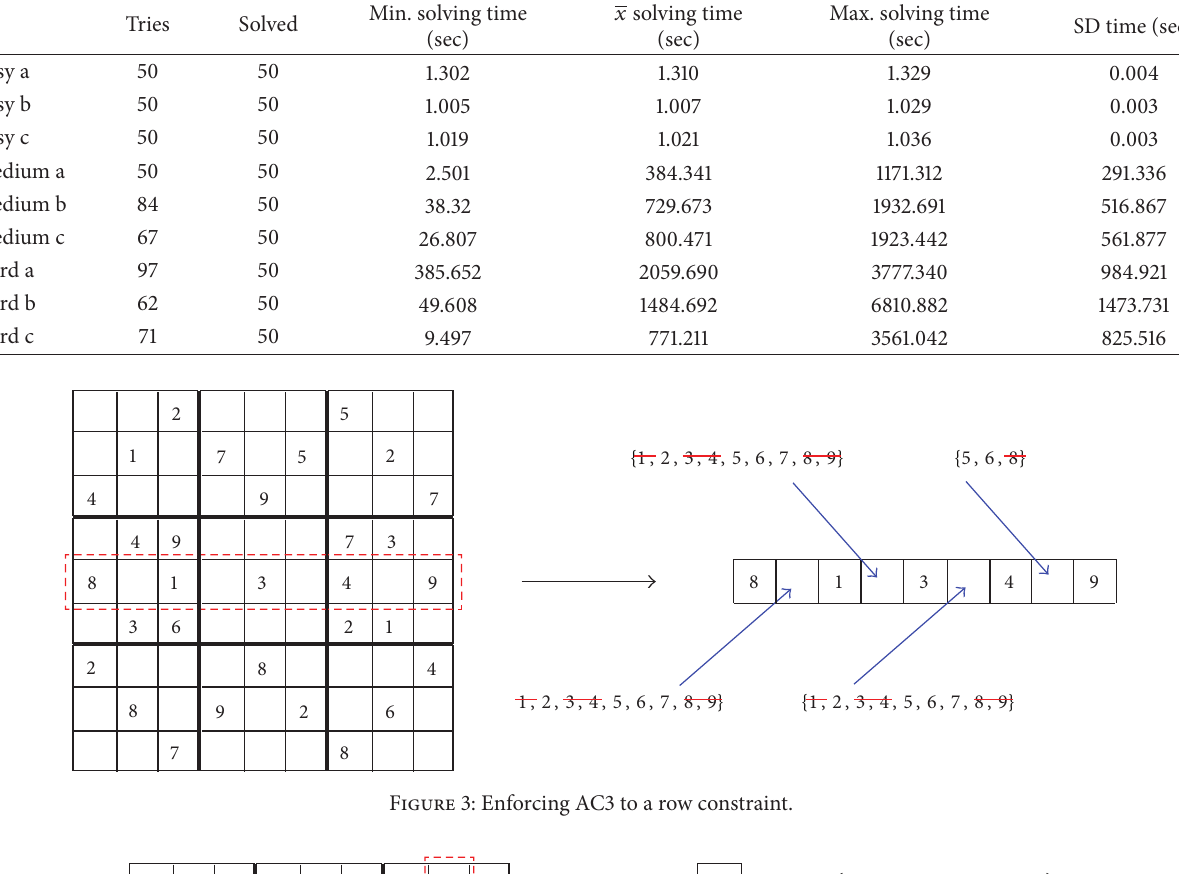
Figure 3: Enforcing AC3 to a row constraint.